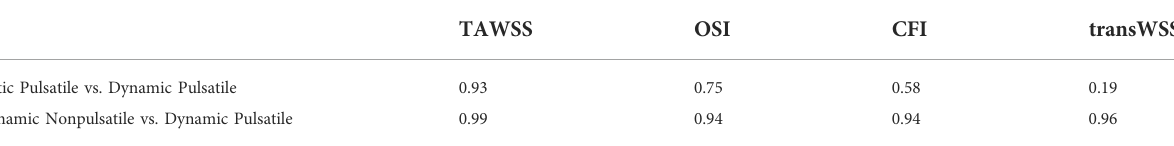
TABLE 1 Spearman rank correlation coef fi cient between different